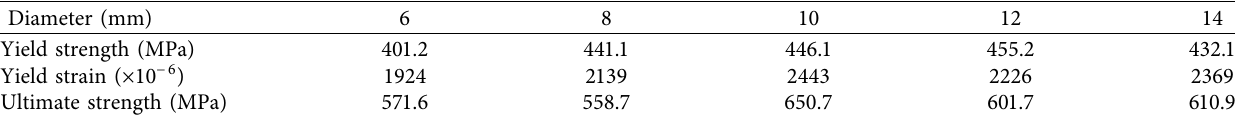
Table 2: Material properties of steel